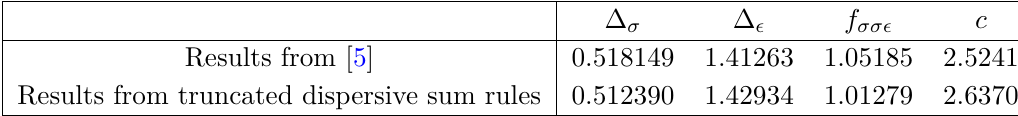
= 42 × 40 points ∆ σ × N ∆ (cid:15)